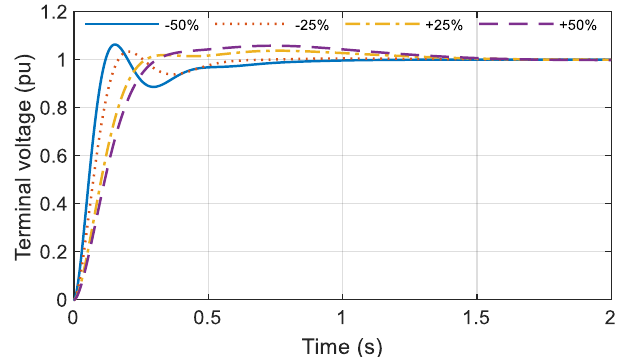
Figure 13. Step response under the variation of T A.